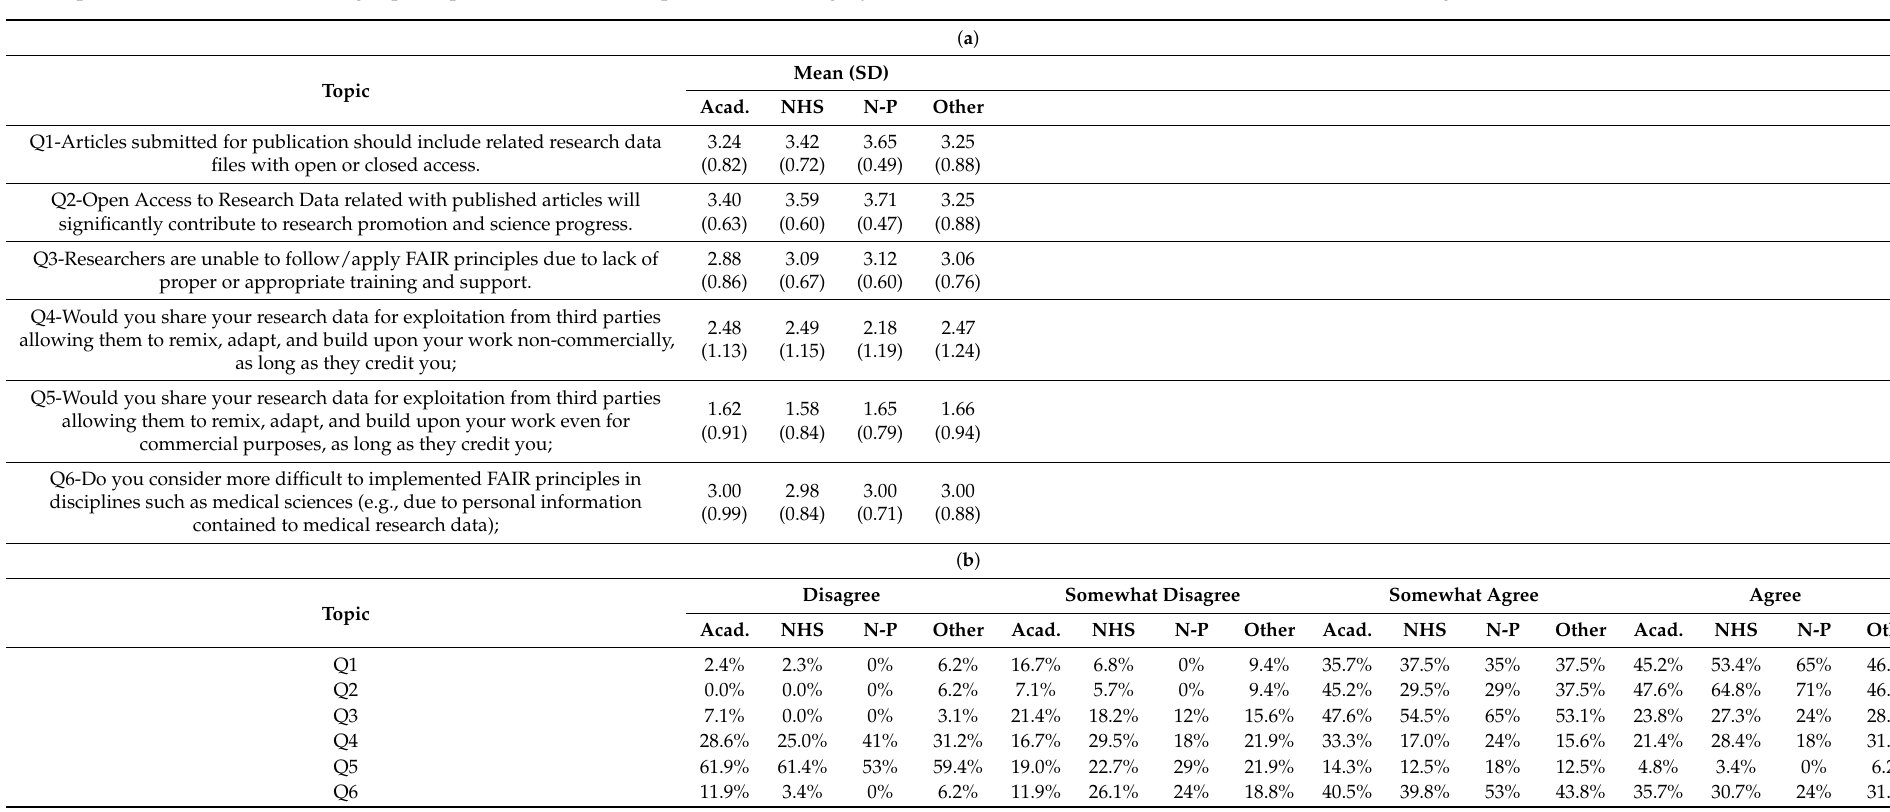
Table 4. ( a ) Define the level of agreement with the following topics regarding Open Research Data-Percentages per topic-Mean and Standard Deviation per topic [Part 2, Q1 to Q6, professional category: Academic Doctors (Acad.), NHS Doctors (NHS), Nursing and Paramedical Staff (N-P), Other]; ( b ) Define the level of agreement with the following topics regarding Open Research Data-Percentages per topic [Part 2, Q1 to Q6, professional category: Academic Doctors (Acad.), NHS Doctors (NHS), Nursing and Paramedical Staff (N-P),